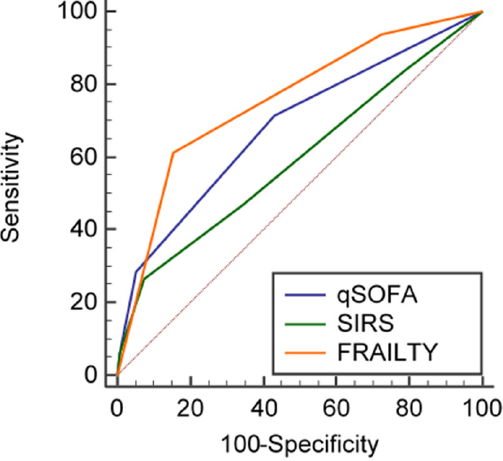
Figure 2. Receiver Operating Characteristic (ROC) curves showing the predictive capacity of qSOFA, SIRS, and frailty (operationalized according to the Rockwood Clinical Frailty Scale) for pooled three-month mortality in the studied geriatric population. Table 4. Logistic regression analysis showing the association of qSOFA score at admission with the secondary study outcome (pooled mortality three months after discharge) in elderly patients with suspected sepsis who completed the study follow-up ( n = 247).